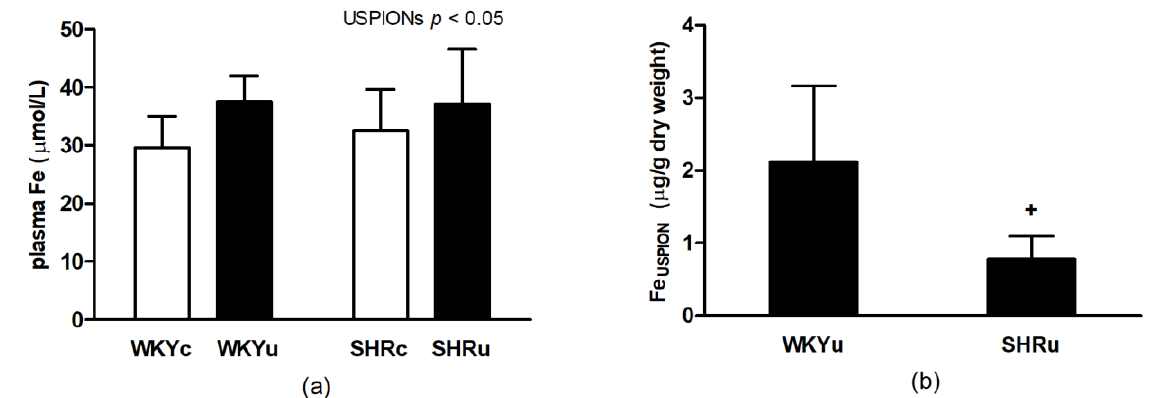
Figure 3. Total iron content in plasma ( a ) and USPION-originated iron content in RBCs ( b ) after the single USPION administration at a dose of 1 mg Fe/kg body weight. Rats were sacrificed approximately 100 min after the USPION administration. Abbreviations: RBCs, red blood cells; USPIONs, ultra-small superparamagnetic iron-oxide nanoparticles; WKY, Wistar Kyoto rats; SHR, spontaneously hypertensive rats; WKYc, control WKY; WKYu, USPION-treated WKY; SHRc, control SHR; SHRu, USPION-treated SHR. The data are presented as means ± SD, n = 6–7 per group ( a ) and n = 5 per group; ( b ) + p < 0.05 vs. WKYu.